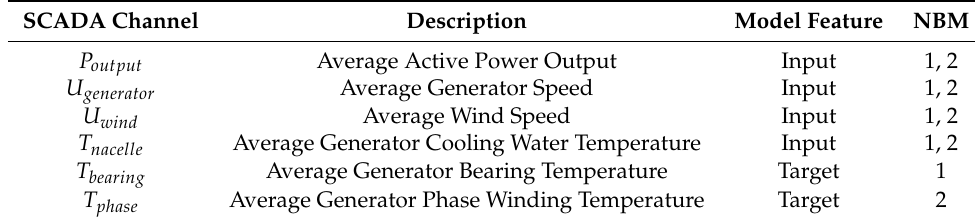
Table 1. SCADA channels used for NBM development.